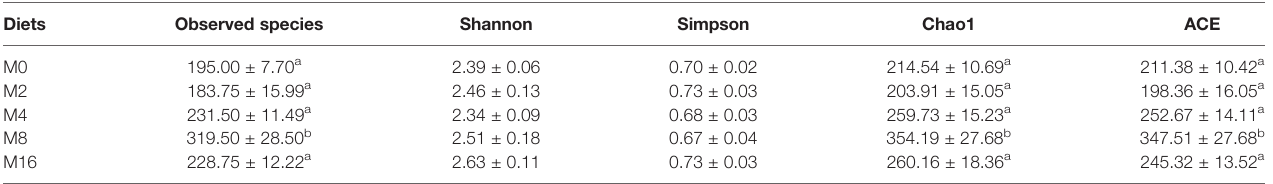
TABLE 3 | Effects of dietary MOS on the alpha diversity of intestinal microbiota in Litopenaeus vannamei . Diets Observed species